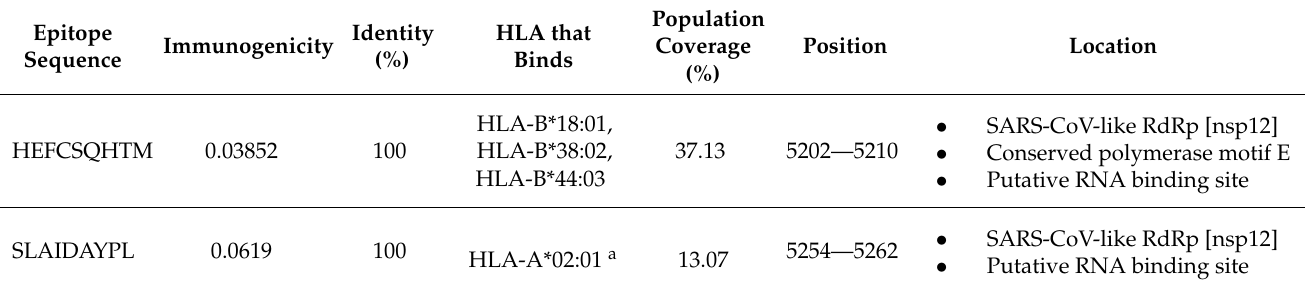
Table 5. List of epitopes that are fully conserved in SARS-CoV-2 ancestral sequence and four other Human CCCs. A total of two 9-mer epitopes originated from ORF1ab found to be 100% conserved in all five viruses.